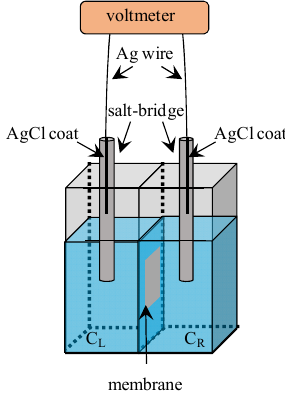
Figure 2. Experimental setup for measuring the potential across a membrane. C L and C R represent the KCl concentration of left and right KCl solutions, respectively.